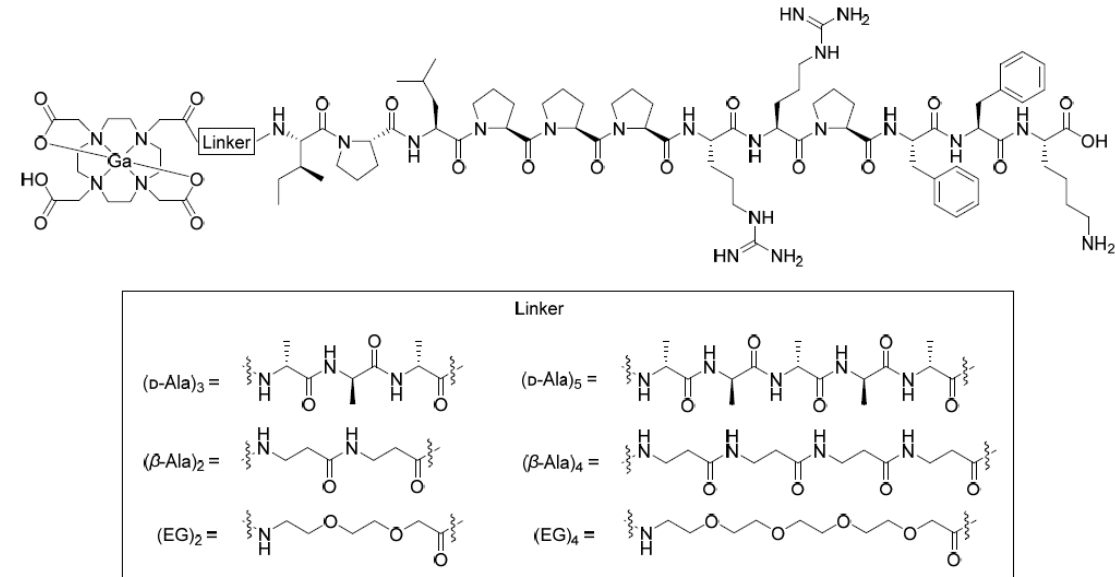
Figure 1. Chemical structures of Ga-DOTA-(linker)-IPLPPPRRPFFK.